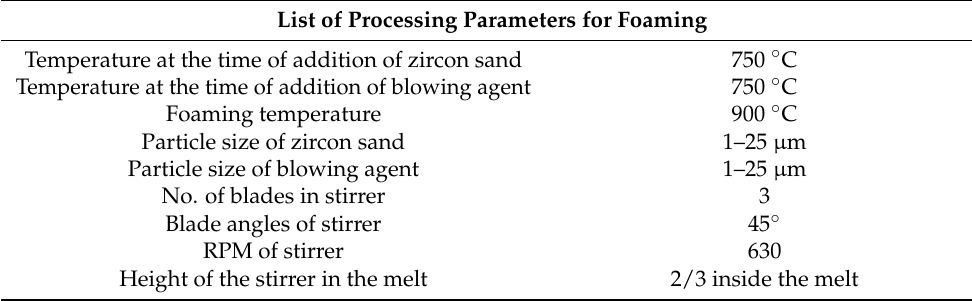
Table 3. List of parameters of the developed metal foams. List of Processing Parameters for